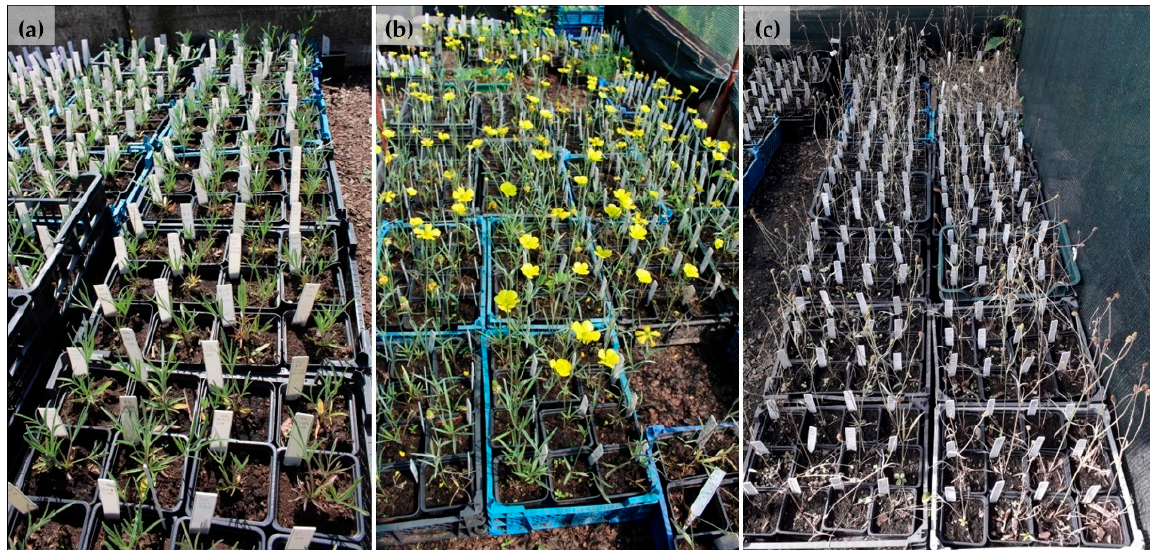
Figure 1. Labelled Ranunculus illyricus specimens growing in the collection: ( a ) vegetative above- ground shoots (20 April 2019); ( b ) flowering (28 May 2019); ( c ) ripening of fruit and die-back of aboveground shoots (24 June 2019).